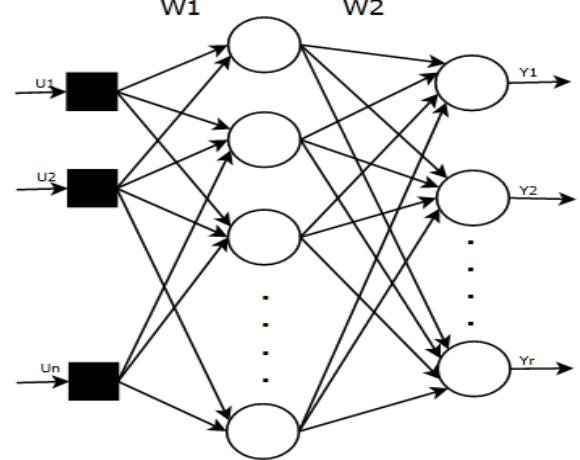
Figure 5. Artificial neural networks (ANN) with one hidden layer.